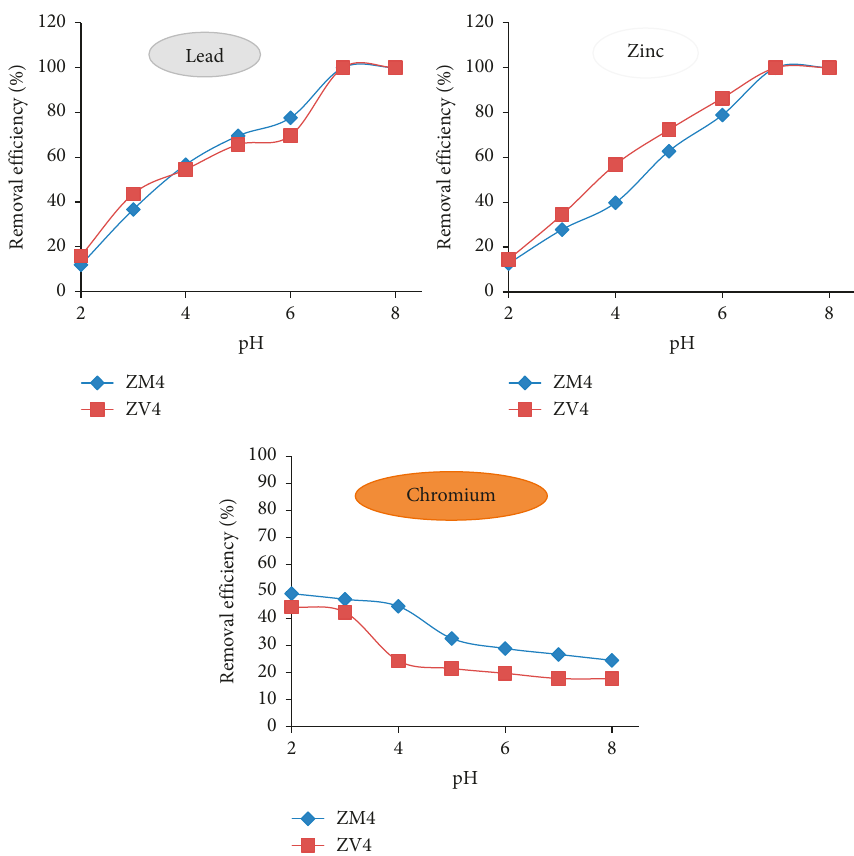
Figure 7: Effect of pH on the removal of heavy metals by ZV4 and ZM4.